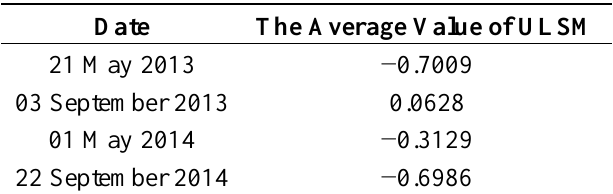
Table 6. The average value of ULSM in “Effective Moisture Areas”.